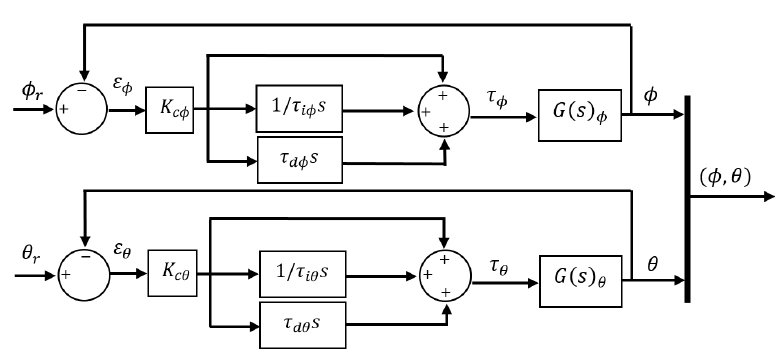
Figure 13. PID control approach with ISA structure.